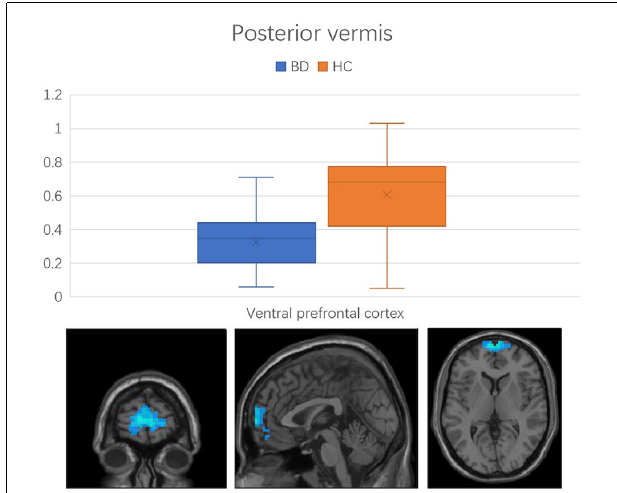
FIGURE 3 | Functional connectivity between the posterior vermis and ventral prefrontal cortex in the comparison between BD and HC groups. Error bars represent the standard deviation of Z values at the peak voxel. BD, bipolar disorder; HC, healthy